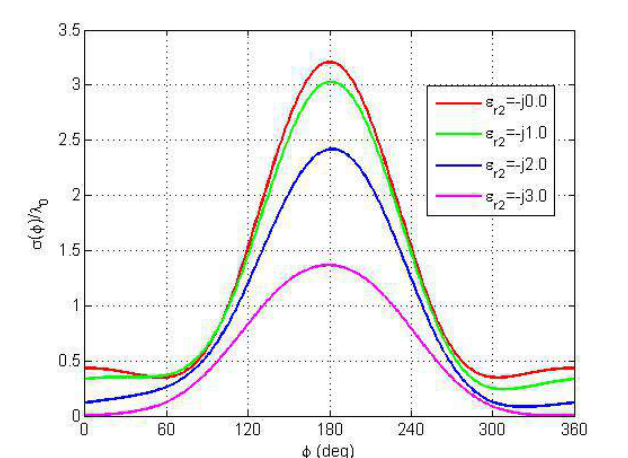
Figure 5: Variation of the normalized bistatic width with the scattering angle, when a gyroelectric elliptic cylinder having an axial ratio of 2 and 𝑘 as well as 𝜀 ! 𝑎 = 0.4𝜋 , !! = 4 , 𝜇 !! = 2, and 𝜀 , is excited by a plane wave of !! = −𝑗0, −𝑗1, −𝑗2, −𝑗3 TE polarization, incident at 0 ! .